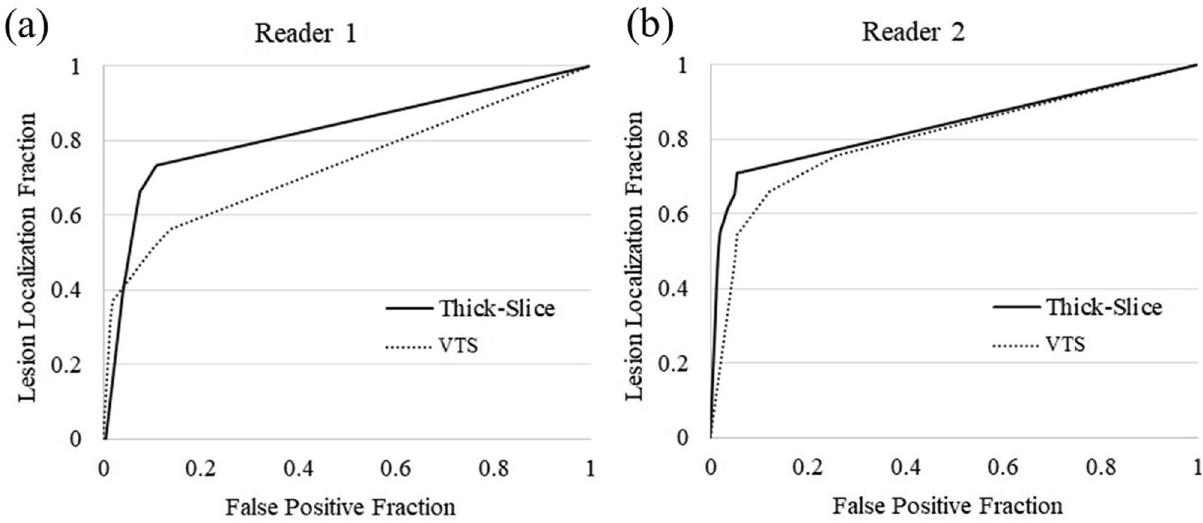
Figure 5. JAFROC curves for Reader 1 ( a ) and Reader 2 ( b ). The figure of merit was significantly higher for thick-slice images than for virtual thin-slice images for Reader 1 ( P =